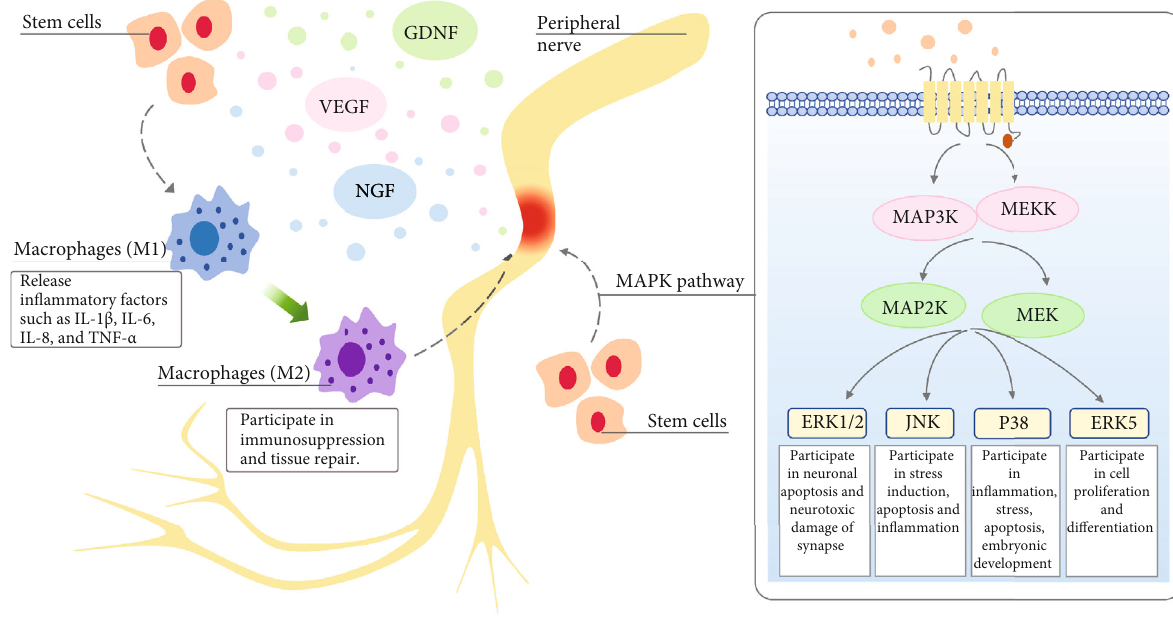
Figure 1: Diagram showing the role of stem cells in peripheral nerve injury and the simpli fi ed MAPK pathway. GDNF=glial-derived neurotrophic factor; IL =interleukin; NGF=nerve growth factor; TNF =tumor necrosis factor; VEGF=vascular endothelial growth peptide (CGRP) in peptidergic neurons and the isolectinB4 (IB4) bound by nonpeptidergic neurons in DRGs. BMSCs